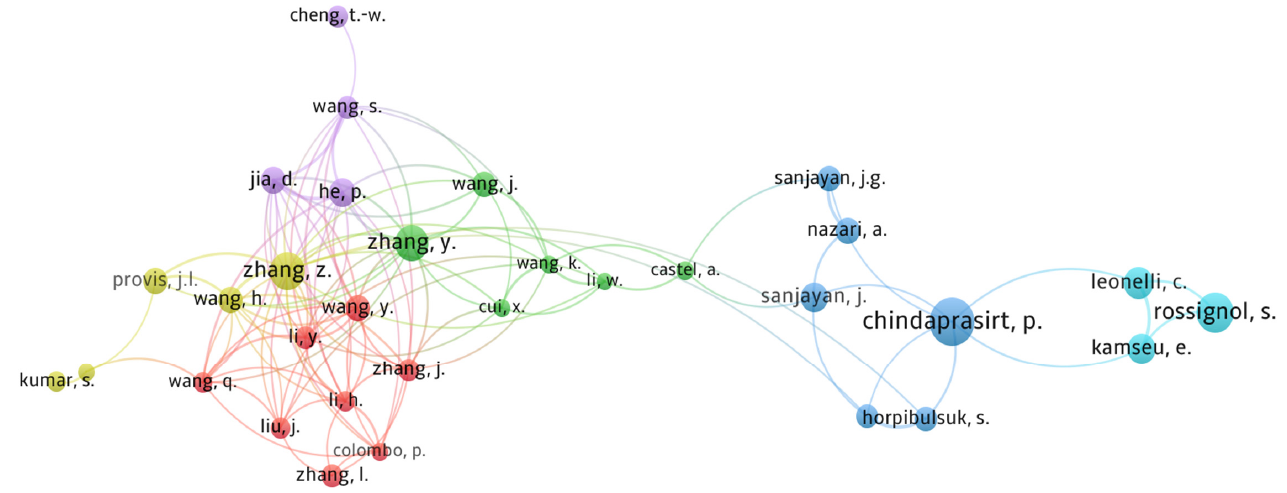
Figure 4. Visualization of authors’ contribution based on citations and co-authorship.